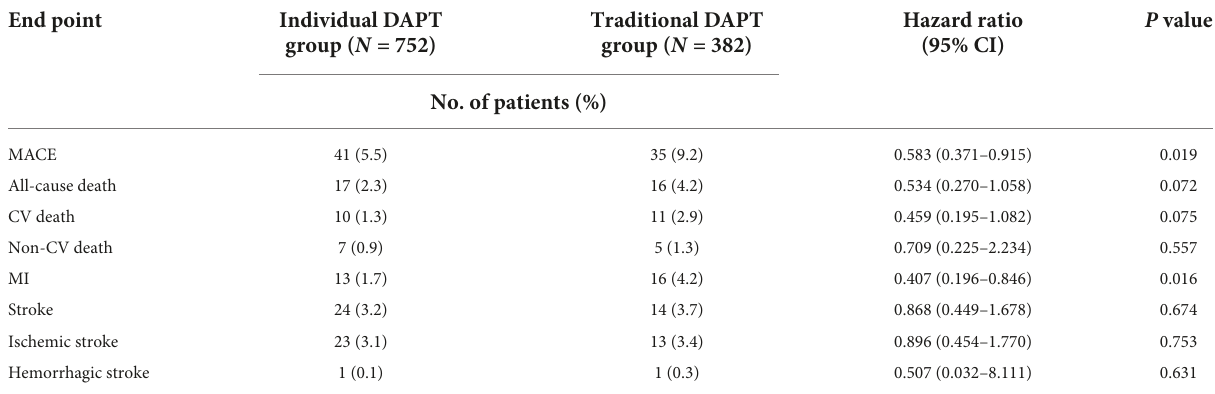
TABLE 3 Endpoints of individual dual antiplatelet therapy (DAPT) group vs. traditional DAPT